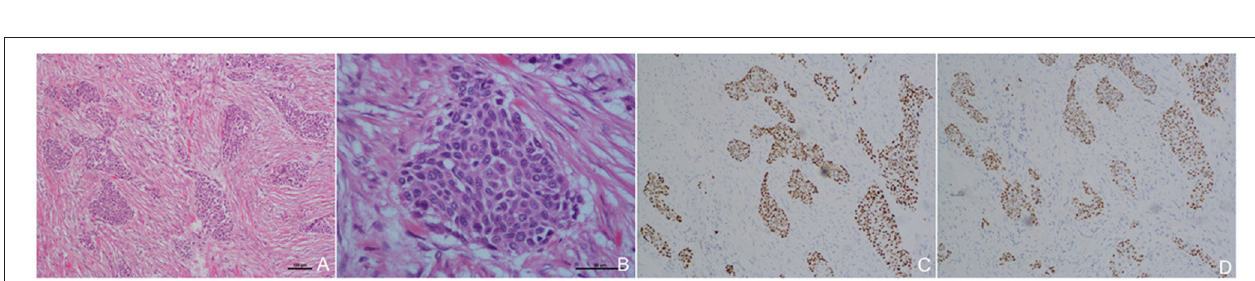
FIGURE 3 | Histopathological and Immuno-histochemical images Low power image (HE × 40) of the carcinoma with squamous cell (A) ; Higher power image with large squamous cell carcinoma nest and characterized by typical keratin pearls in histopathological assessments, without glandular component (B) . Immuno-histochemical showed p63 ( + ), p40 ( + ), and P63 and P40 as specific marker of squamous cell carcinoma (C,D)